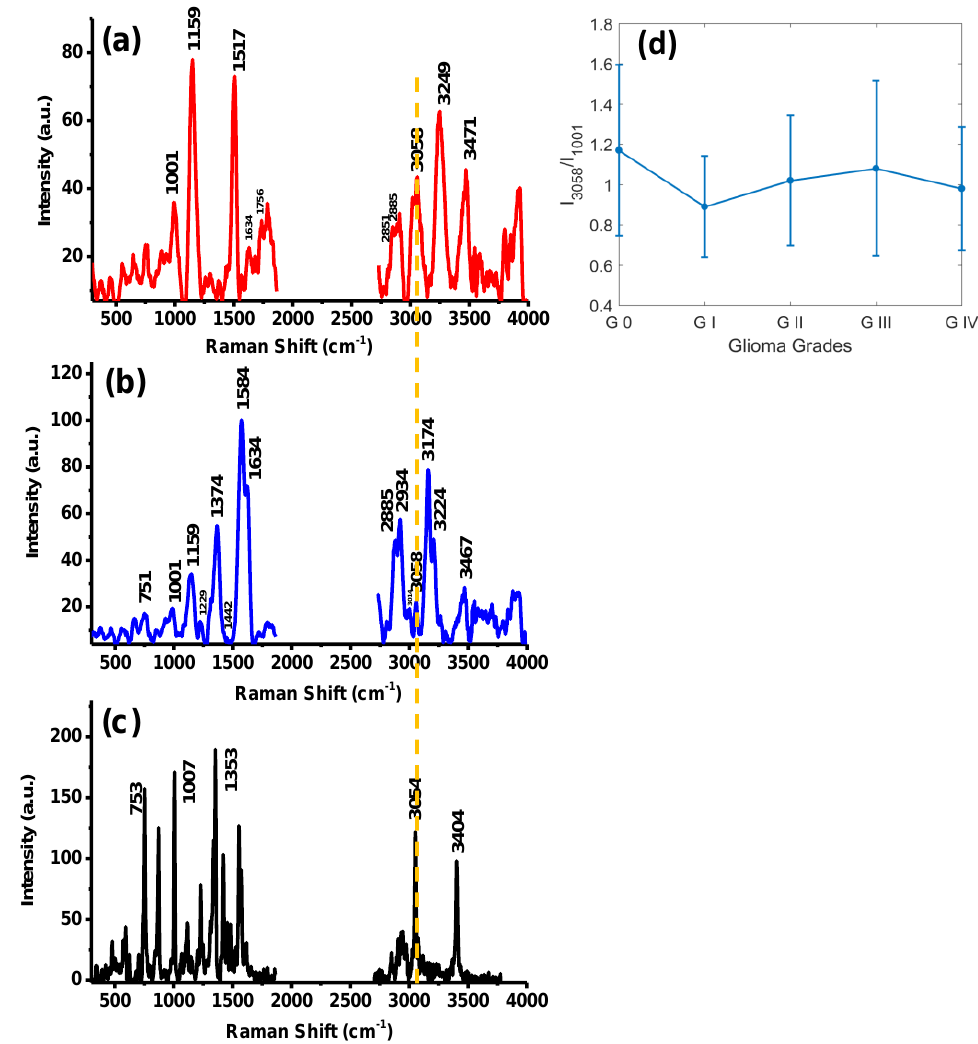
Figure 4. Typical VRR spectra of ( a ) normal/control of glioma margin tissue, ( b ) glioma grade 4 tissues, and ( c ) tryptophan powder, along with ( d ) the content of the RR mode around 3058 cm − 1 of tryptophan versus glioma grade. Raman peak of 3058 cm − 1 was normalized by RR peak at 1001 cm − 1 of phenylalanine. G0, normal; G I, grade 1; G II, grade 2; G III, grade 3; and G IV, grade